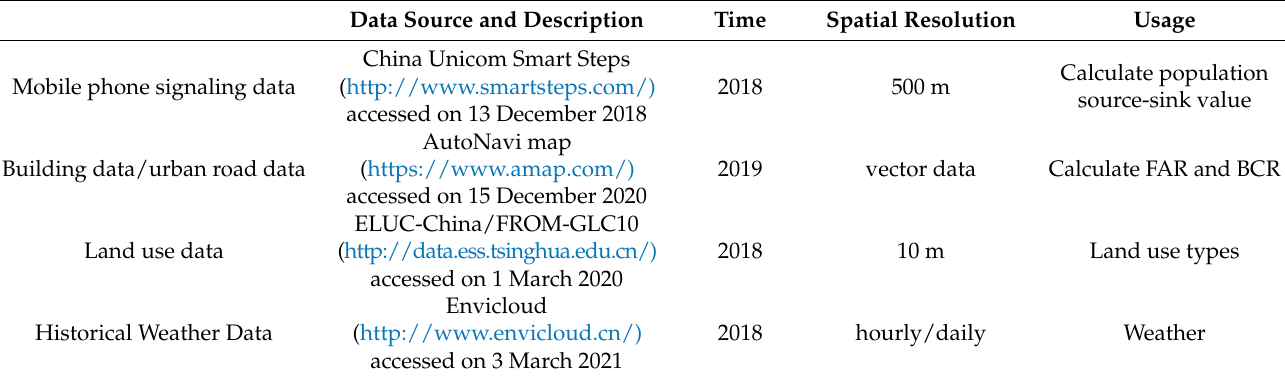
Table 1. Data sources and information.